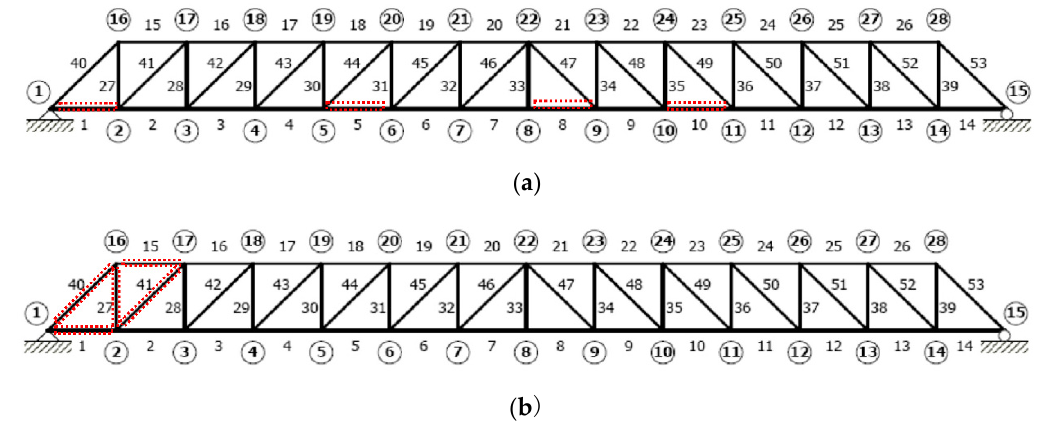
Figure 4. ( a ) Selection of scattered measuring points of the lower chord. ( b ) Selection of centralized measuring points at the support. Table 6. Calculation results with centralized measuring points of the lower chord.